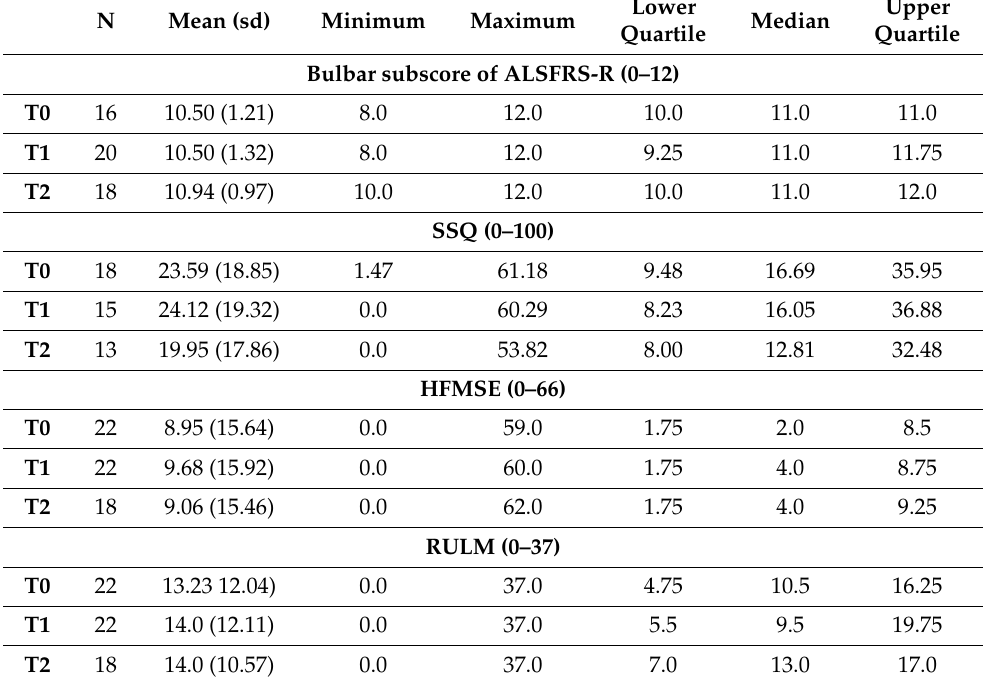
Table 2. Descriptive statistics for the bulbar subscore of the ALSFRS-R, SSQ, HFMSE and RULM at T0 (baseline), T1 (6 months) and T2 (14